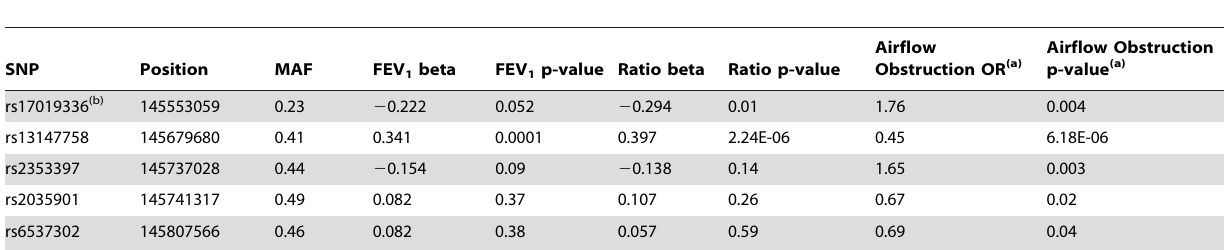
Table 4. SNP association results for the Family Heart Study smokers (N= 485) in the chromosome 4 region.